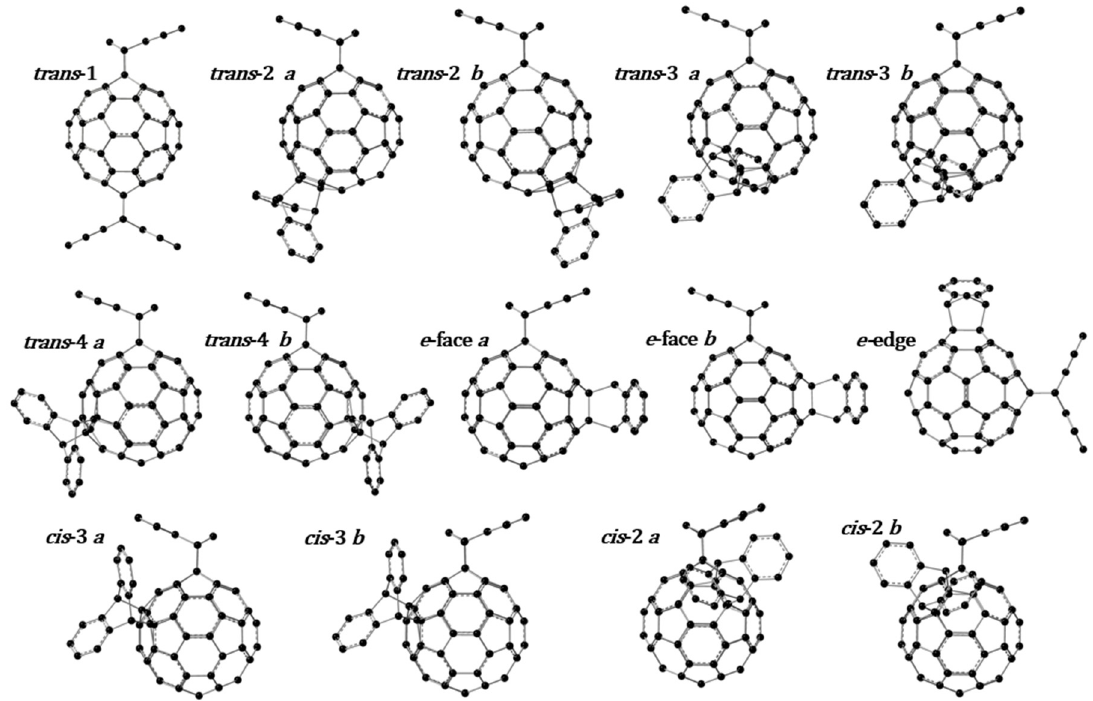
Figure 4. Optimized molecular structures for 14 regioisomers of AIC 60 BA (IC 60 MA adducts with anthracene); only the four cis -1 isomers were excluded from the computational study due to obvious steric repulsions. With exception of trans -1, e -face a , and e -face b , all the regioisomers presented have a corresponding enantiomer, making up a total of 29 isomers (if including the four cis -1).